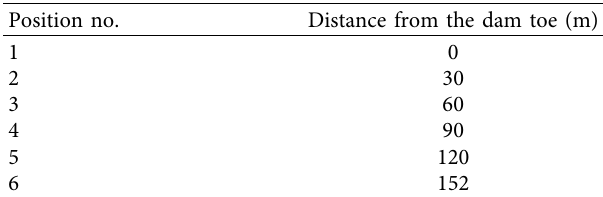
Figure 14: Percentage change of exit gradient in different cases of horizontal drainage length. Table 7: Different positions of horizontal drainage (with a length of 30 meters of horizontal drainage).